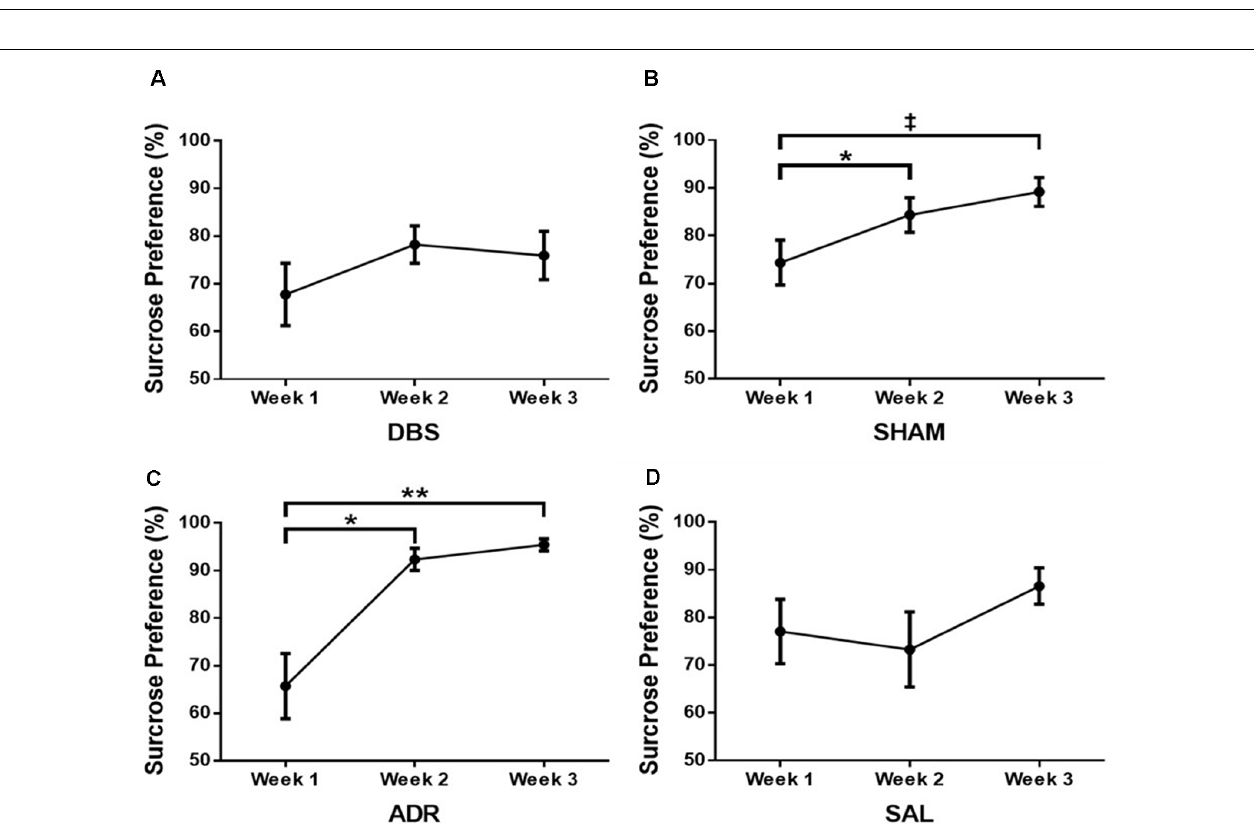
FIGURE 6 | Sucrose preference test at each week for (A) DBS, (B) sham, (C) ACTH, (D) saline groups. Data are shown as mean ± standard error. Significance is illustrated on graphs by * p < 0.05; ** p < 0.01. Trends illustrated as ‡ p <